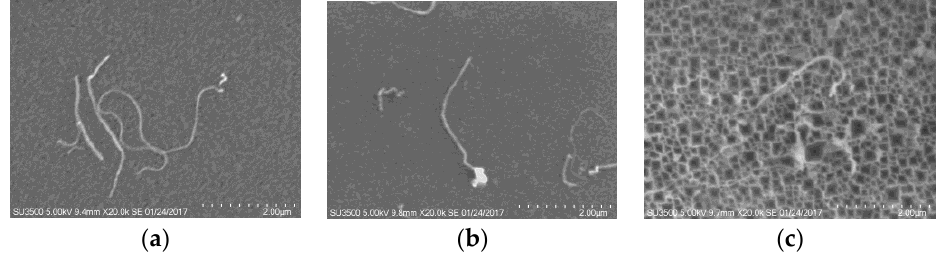
Figure 4. SEM s urface morphology micrographs of PSi with MWCNTs dispersed by spin coating. PSi layers were etched at currents: ( a ) 10 mA, ( b ) 50 mA and ( c ) 100 mA, all for 600 s time etching.